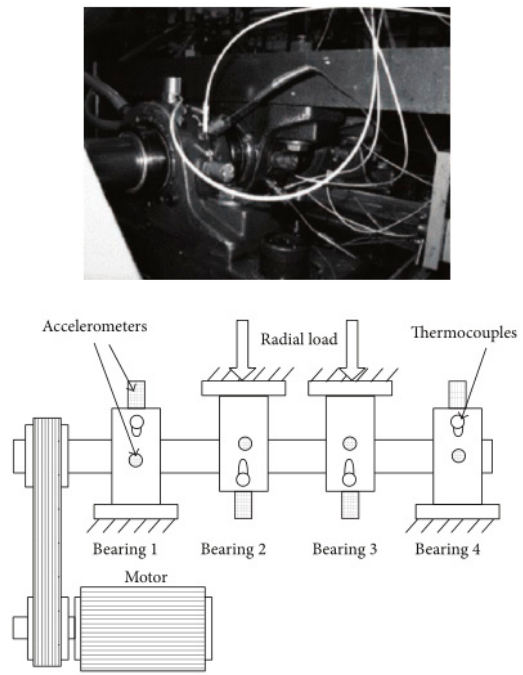
Figure 5. The schematic diagram of experimental bearing structure [27].